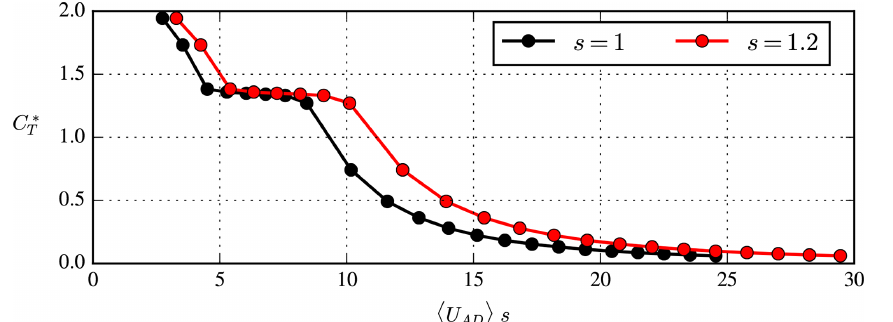
– (cid:104) U AD (cid:105) curve used for AD control in wind farm simulations. Scaling parameter s is used to represent different Figure 1. Precalculated C ∗ T wind